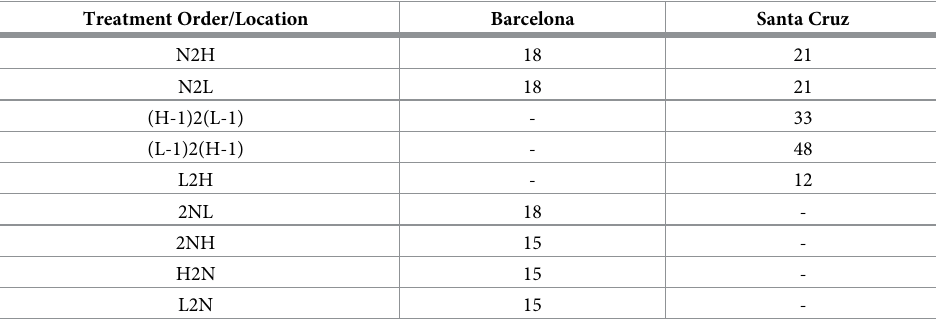
Table 2. Participants per treatment.